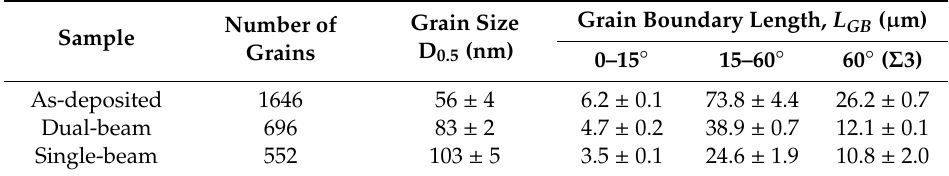
Table 1. Summary of grain size and GB characters for as-deposited, dual-beam irradiated, and single-beam irradiated NC Cu, collected from a large area (11.06 µ m 2 ) at three di ff erent locations. D 0.5 : the median grain size when P =